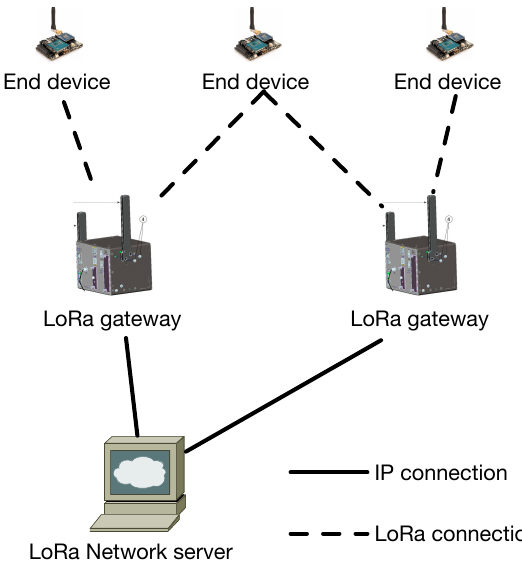
Figure 1. LoRa network